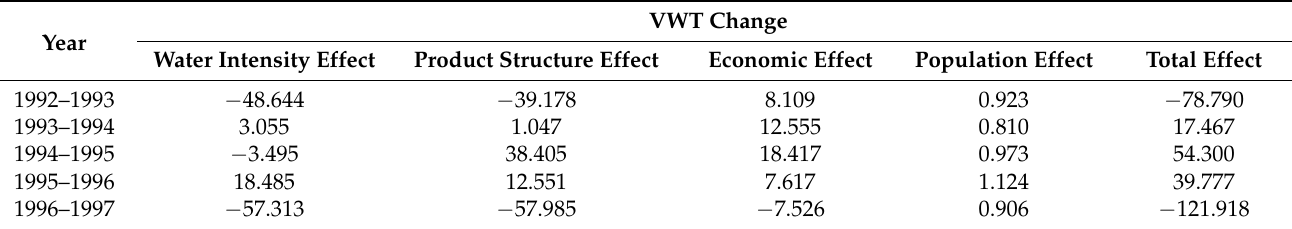
Table A1. The logarithmic mean divisia index (LMDI) analysis of barley virtual water trade (VWT) change in South Korea (million m 3